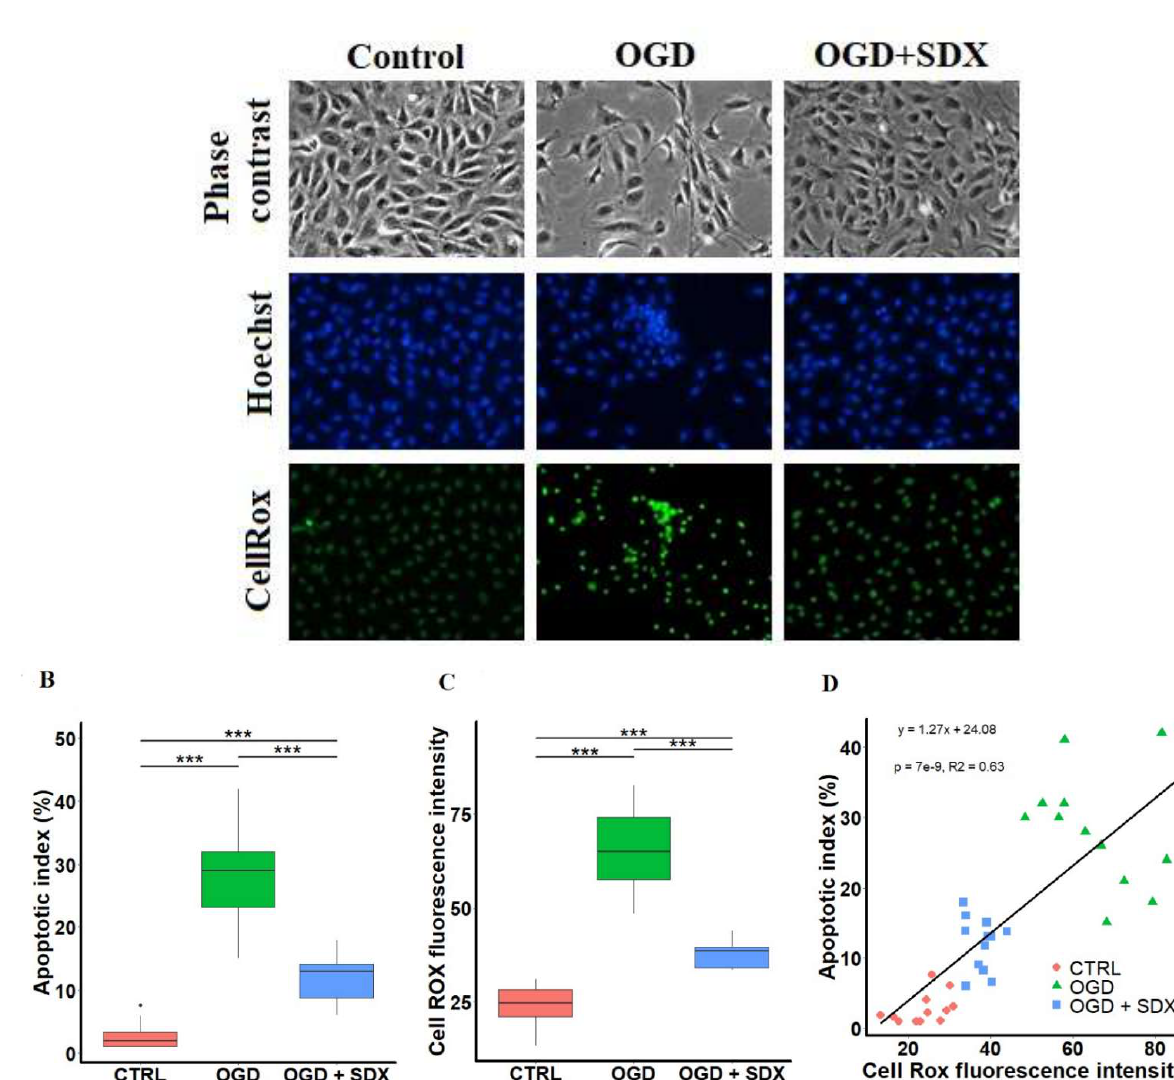
Figure 1. SDX cytoprotective effects against oxidative damage induced by OGD in human endothelial cells. HUVECs were treated for 6 h in OGD in the absence or presence of SDX (0.5 LRU/mL). ( A ) Microscopic observations. Morphology was visualized and photographed under an inverted phase contrast microscope (original magnification ×200). Apoptotic cells were identified by Hoechst 33342 staining and intracellular ROS production was observed using CellROX Green Reagent. The images were examined under a fluorescence microscope (original magnification ×200). Control: normal conditions; OGD: cells exposed to simulated ischemia in vitro only; OGD + SDX: cells exposed to simulated ischemia in vitro and treated with SDX. Apoptotic index ( B ) and quantification of CellROX green fluorescence intensity ( C ) in each corresponding group ( n = 12). Data in panels ( B , C ) are box-plots representing the median and quartiles with the upper and lower limits. Significant results are marked with asterisks (*** p < 0.001); ( D ) Correlation between apoptotic index and ROS production. Apoptotic index and ROS generation were determined as described in panel ( A ). Pearson’s correlation coefficient R 2 = 0.63 was calculated from the linear regression analysis between apoptotic index and CellROX green fluorescence intensity. Control group. [ · ] is the oulier. As shown in Figure 2A, the SDX treatment for 1 and 3 h in OGD significantly ele- vated the intracellular tGSH (median 29.12 nmol/mg protein, range 26.96–33.64;